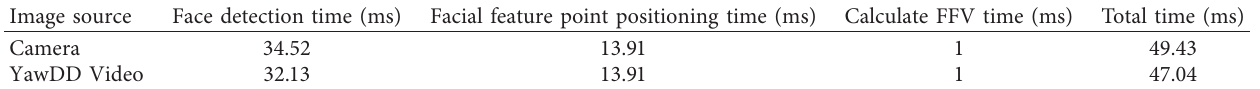
Table 3: The time spent in fatigue status judgment.